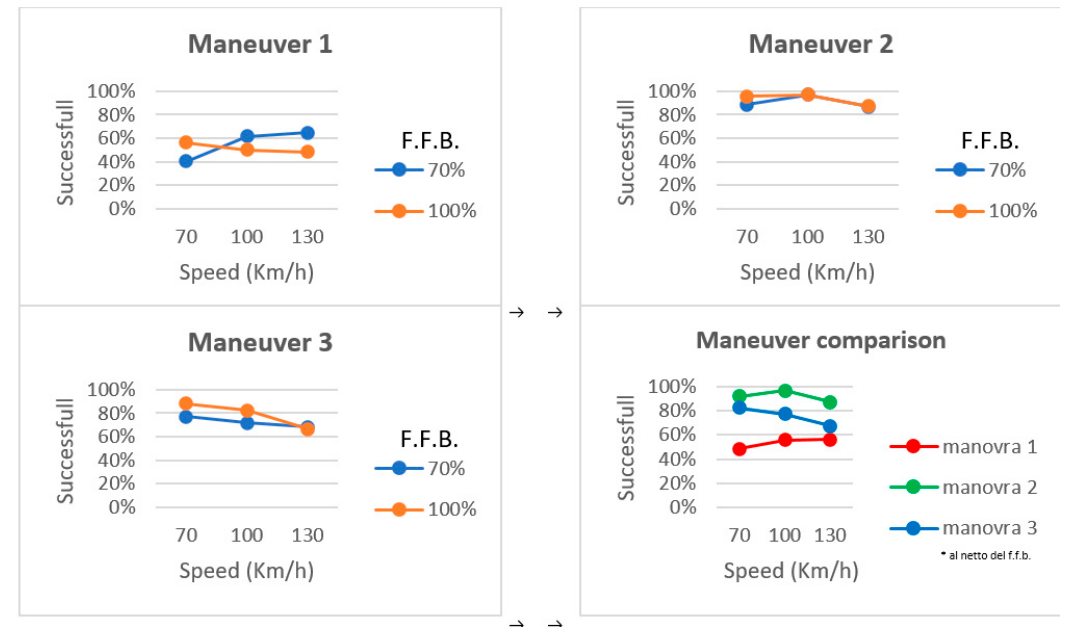
Figure 5. Success percentages of the three maneuvers. F.F.B., force feedback.